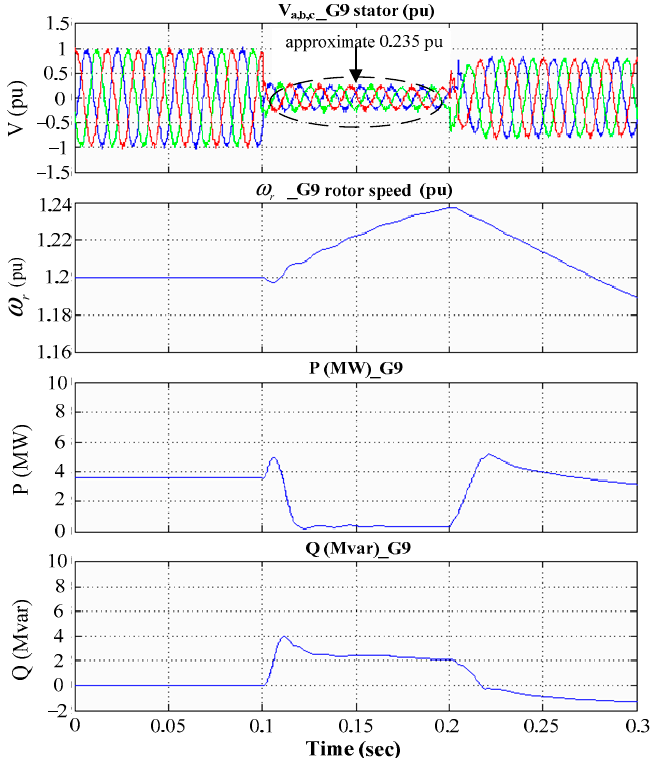
Figure 10. Responses of stator voltage, the rotator speed, and real and reactive power measured in